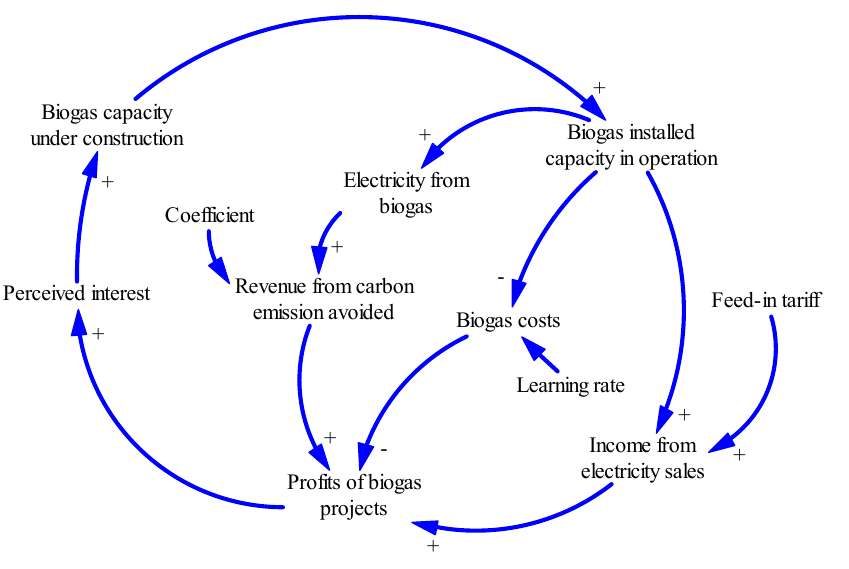
Figure 1. The diffusion of biogas Figure 1. The di ff usion of biogas projects.